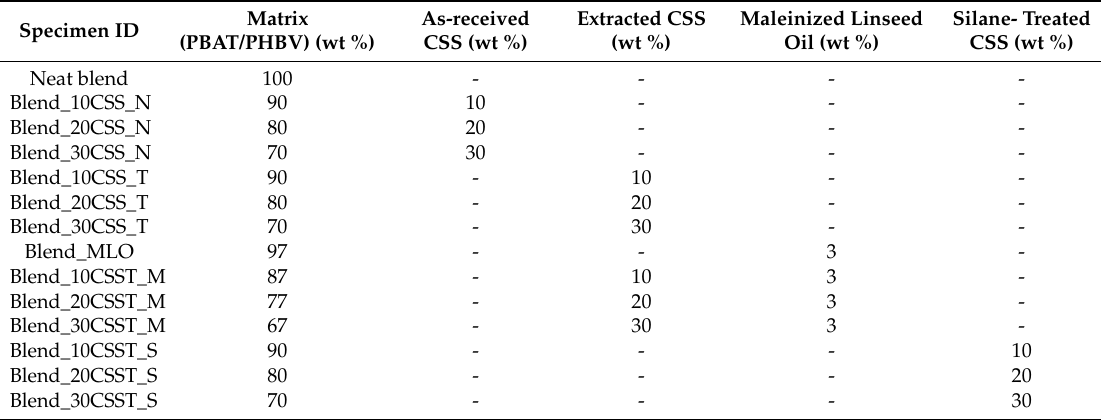
Table 1. Summary of the formulations investigated in the present